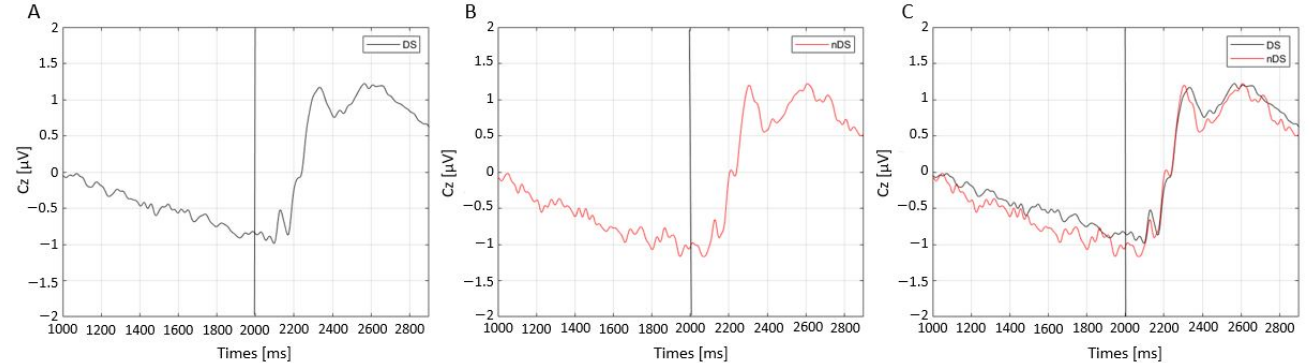
The CNV trends were plotted for both DS (Figure 4A) and nDS (Figure 4B) and the conditions (DS, nDS). In general, the results showed a smaller negative slope preceding the presentation of the imperative go stimulus (which occurs at 2000 ms) in the DS condition compared to the nDS one, as shown in Figure 4C.